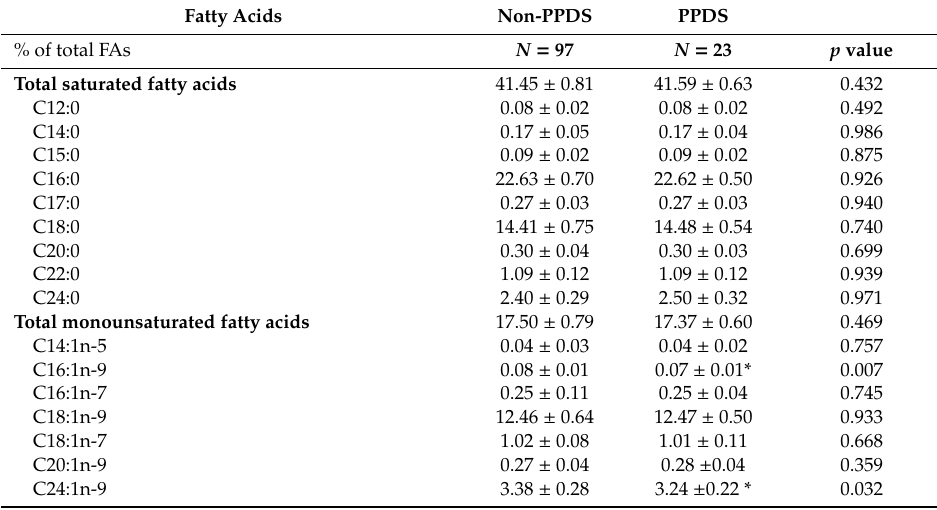
Table 3. Fatty acids composition of erythrocytes a